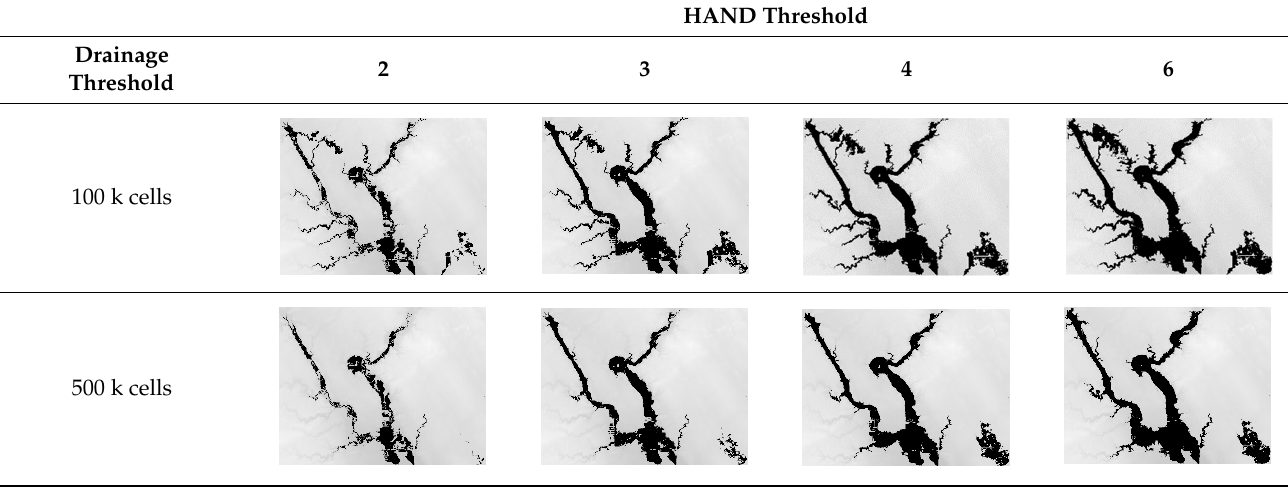
Table 2. Sensitivity of model parameters (HAND threshold and drainage threshold) on the result- ing flood extent (absolute threshold 225 ft).